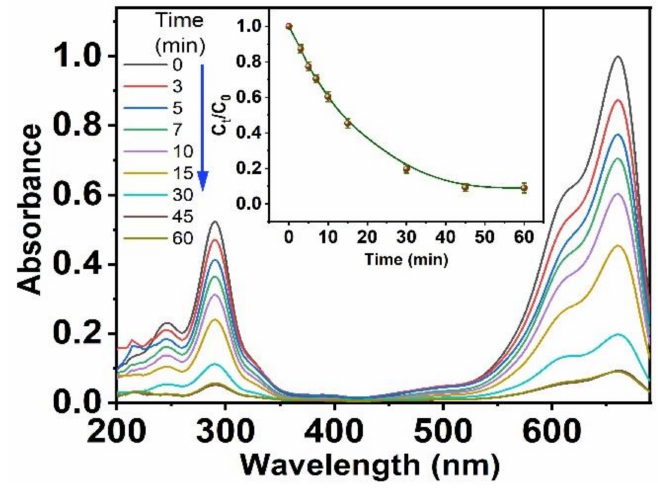
Figure 7. Absorbance spectra of methylene blue in the presence of RuZnO@g-C 3 N 4 photocata- lyst nanoparticles.